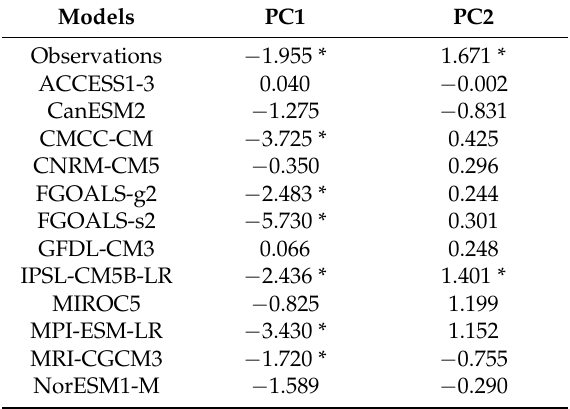
Figure 7. First EOF mode of the geopotential height at 500 hPa in individual CMIP5 models and their variance contribution (top right in each panel). ( a – l ) represent different CMIP5 models as indicated at top left in each panel. Table 2. Linear trend of the empirical orthogonal function (EOF) mode time series in the observations and CMIP5 models. “*” denotes the results exceeding the significant test at 90% confidence level, unit: /10a.